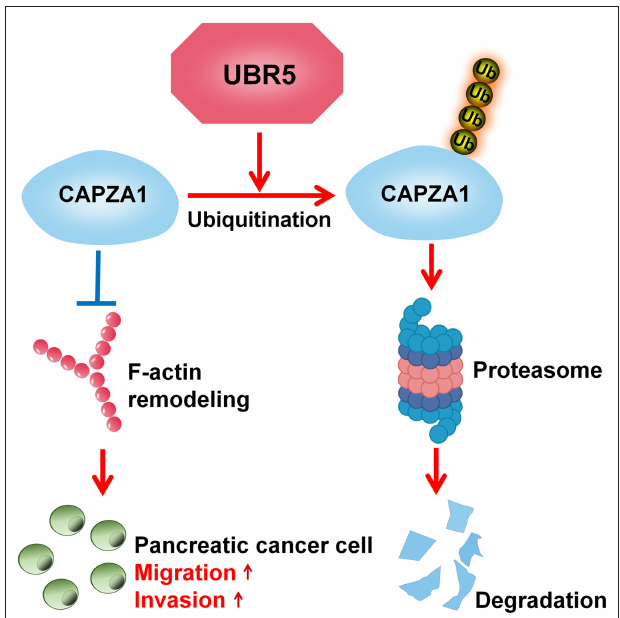
FIGURE 6 | Schematic diagram of UBR5 promoting pancreatic cancer metastasis. A model depicting the role of UBR5 in pancreatic cancer. E3 ubiquitin ligase UBR5 mediates the ubiquitin-proteasome-dependent degradation of CAPZA1, which in turn enhances pancreatic cancer metastasis via promoting F-actin